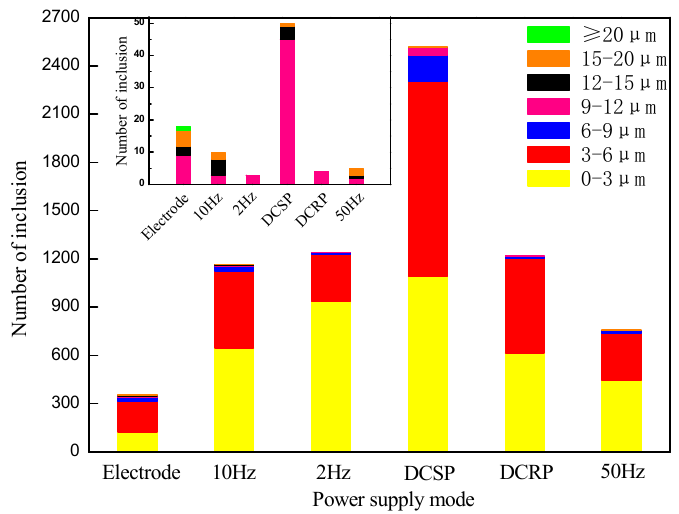
Figure 4. Effect of Power supply mode on number and size of inclusion.